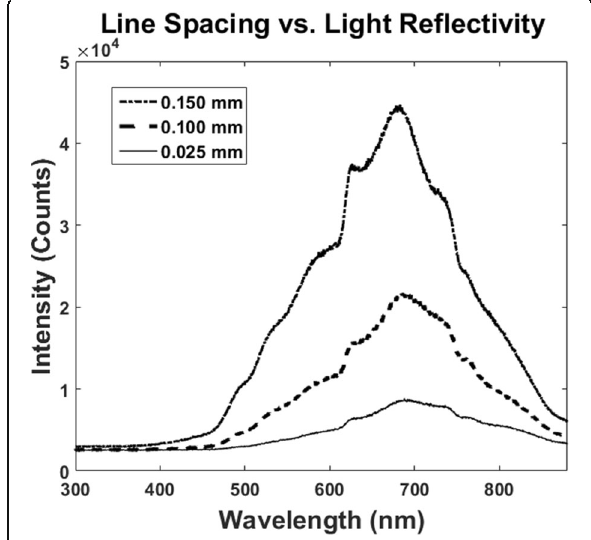
Fig. 5 Light reflection of laser-treated silicon samples at one overlap (OL) and line spacings of 0.025, 0.10, and 0.15